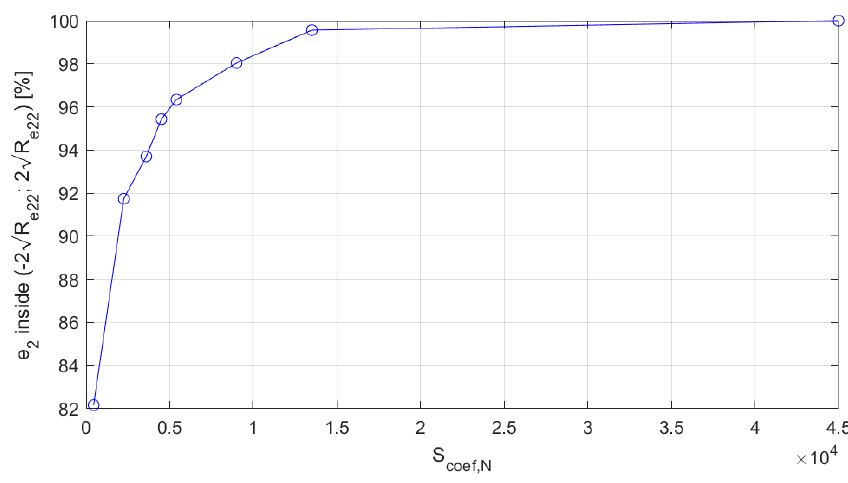
Figure 3. Influence of the 𝑆 𝑐𝑜𝑒𝑓,𝑁 coefficient on the e 2 statistics.